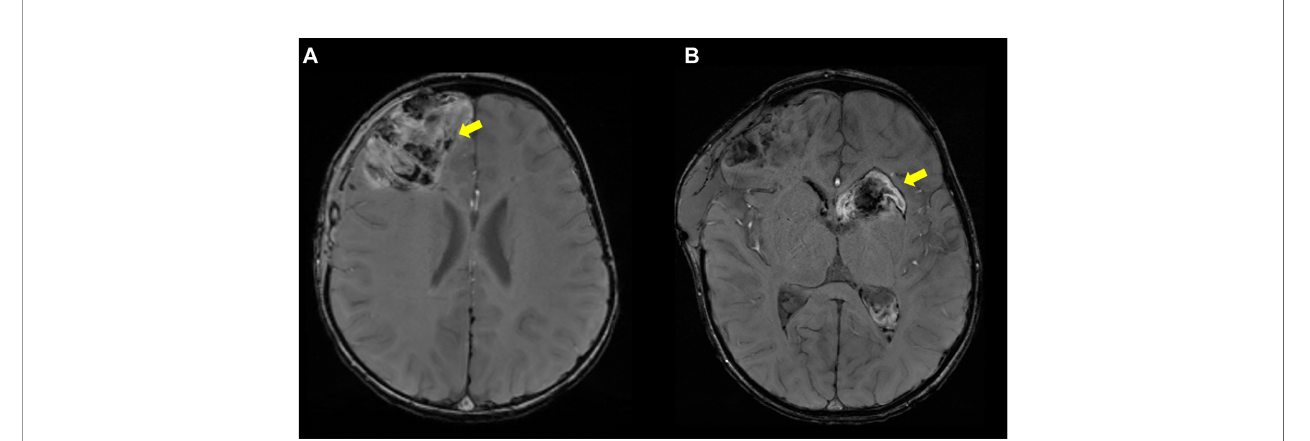
FIGURE 5 | Hemorrhagic Strokes in DADA2. (A) Axial susceptibility weighted imaging (SWI) sequence showing right frontal intraparenchymal hemorrhage in a 2 year 5-month-old patient. (B) Axial SWI sequence showing left basal ganglia hemorrhage extending into the right lateral ventricle in same patient, now 2 year 6 months old. Notably, the patient was not on any anticoagulation prior to her